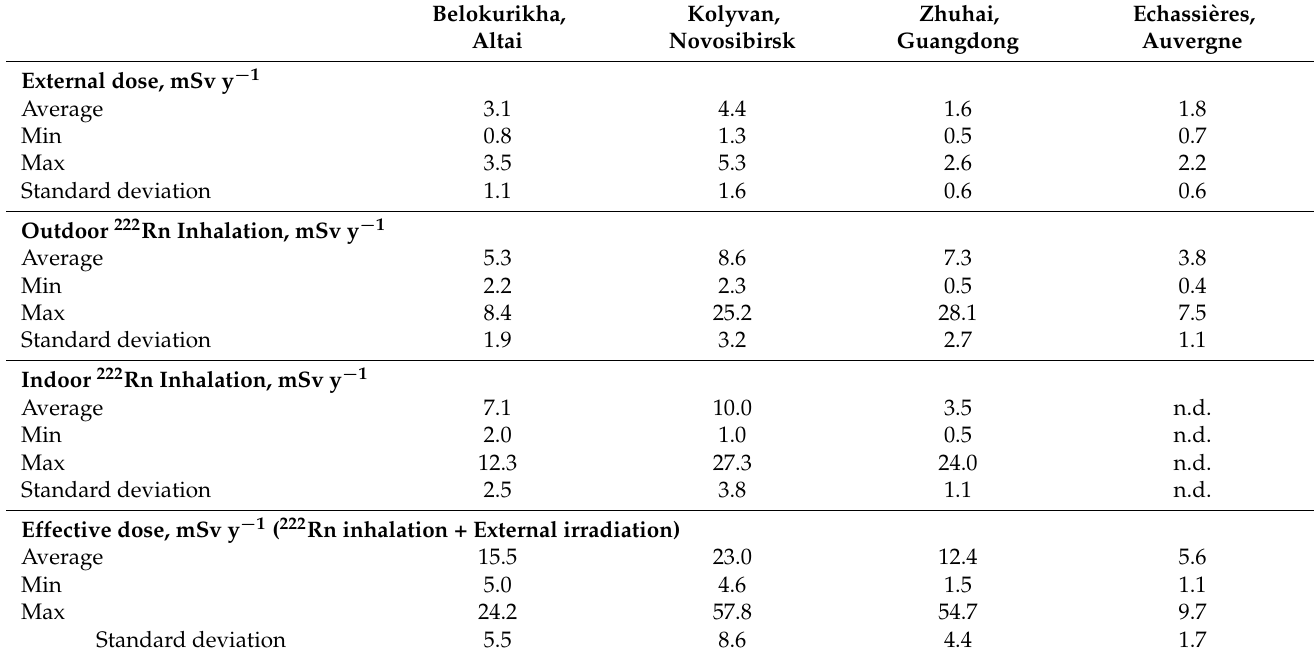
Table 2. Estimated effective doses for inhabitants of the four high natural radiation